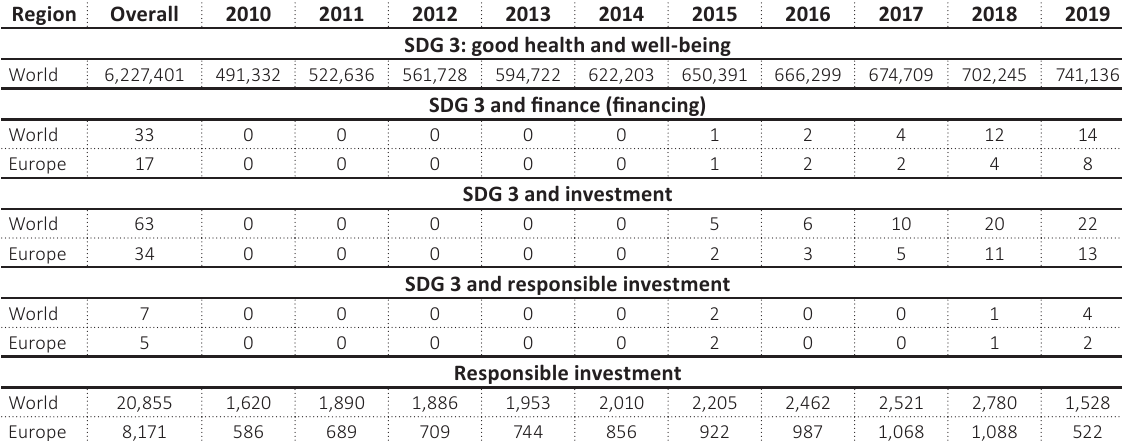
Table 3. Dynamic analysis of SDG 3 and investment coverage in academic literature over the period 2010–2019 as of March 31, 2021